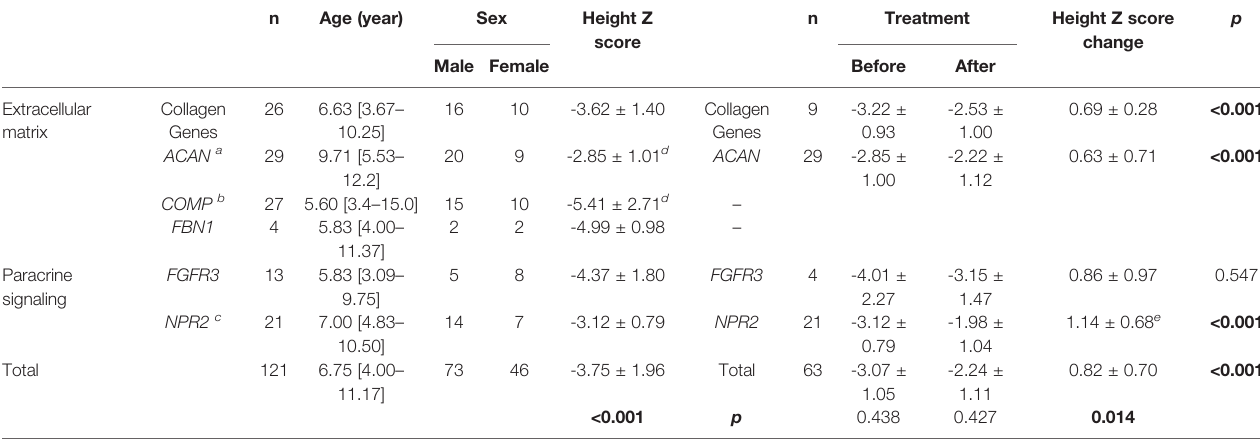
TABLE 4 | Comparison of collagen gene-related short stature with other short stature genetic architecture.